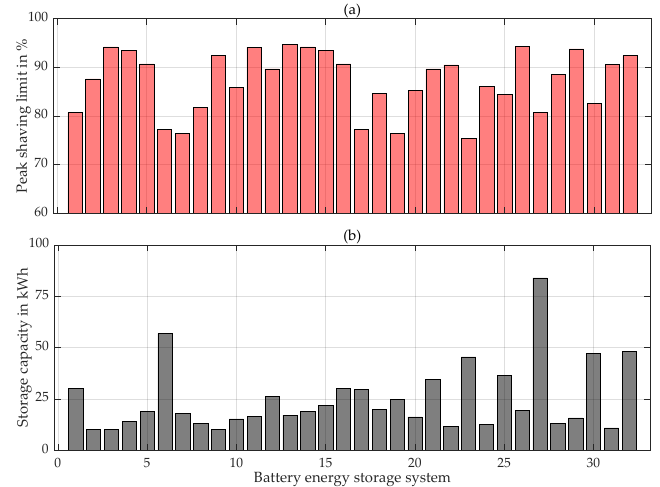
Figure 5. Results of the component sizing optimization. The upper plot ( a ) shows the peak shaving limits S thresh,b in % of the original peak power for all 32 battery energy storage system (BESS) with a capacity above 10kWh. The lower plot ( b ) shows the capacity for just these BESS.